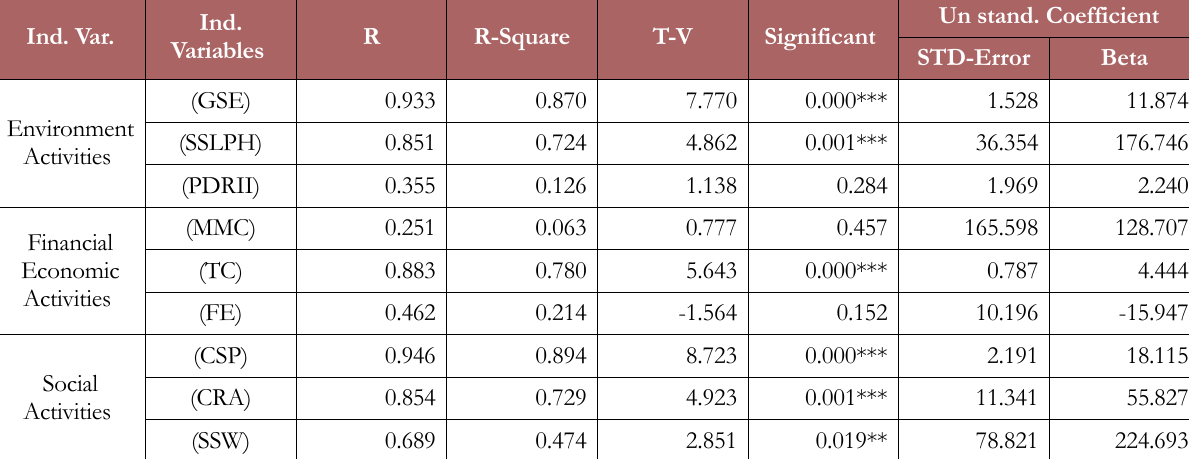
Table 2. Simple regression analysis of each green logistics activity and M1 narrow